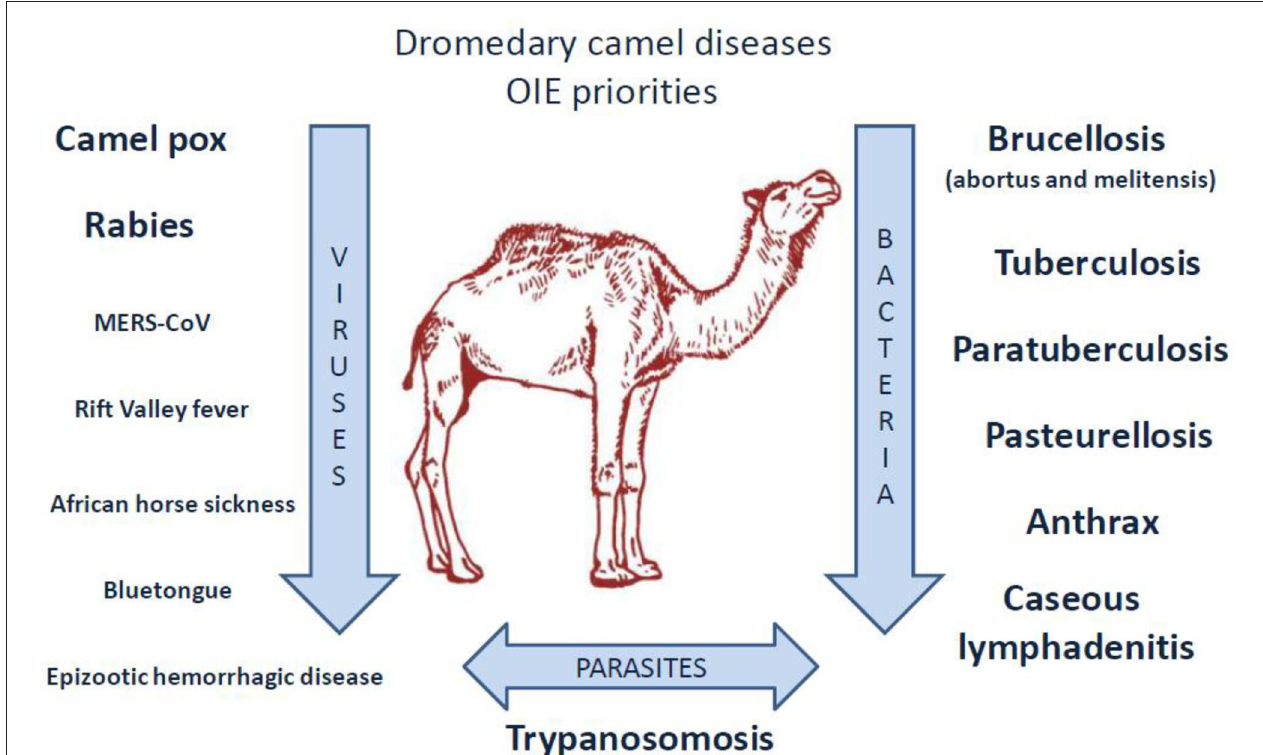
FIGURE 3 | Priority diseases of camelids according to OIE (240). A list of diseases affecting camels and that appear to be priorities for the OIE to improve diagnostic capacity and establish guidelines for trade of camels and camel products was drawn up in 2014 by the OIE ad hoc Group on camel diseases. These experts divided the priority diseases into three groups: (1) significant diseases; (2) diseases for which camelids are potential pathogen carriers; (3) minor or non-significant diseases. Regarding the priority viral diseases (significant diseases), only camelpox and rabies were listed [foot and mouth disease (FMD) that concerns bactrian camels only, also belonged to the list]. The ad hoc Group classified MERS-CoV, Rift valley fever, and orbivirus-induced diseases (BT, AHS, EHD) among the diseases for which camelids are potential pathogen carriers (the bovine viral diarrhea that concerns the New World camelids also belonged to that list). Regarding bacteria, the ad hoc Group classified brucellosis, tuberculosis, paratuberculosis, anthrax, caseous lymphadenitis, and pasteurellosis in the significant diseases category. Trypanosomosis was classified in the significant parasitic diseases of camelids. It should be noted that coxiellosis is not mentioned in the lists of priority camel diseases for the World Organization for Animal Health, OIE. However, C. burnetii has been classified as a notifiable animal disease by this international office (